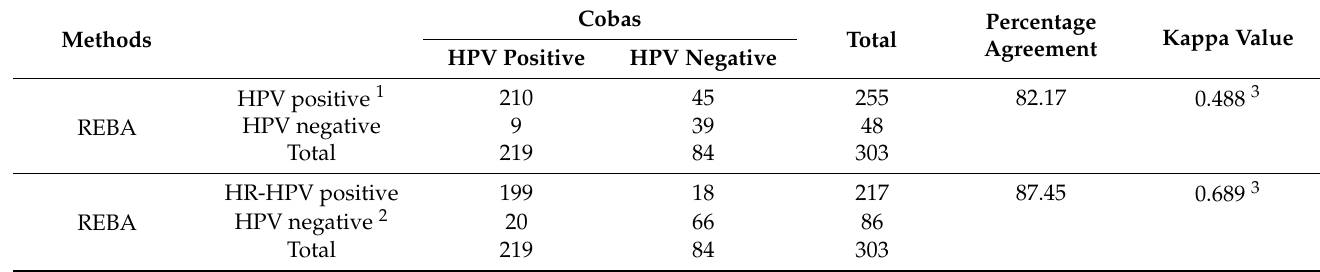
Table 2. Comparison of HPV detection between the cobas ® 4800 and REBA-HIV-ID ® assays.